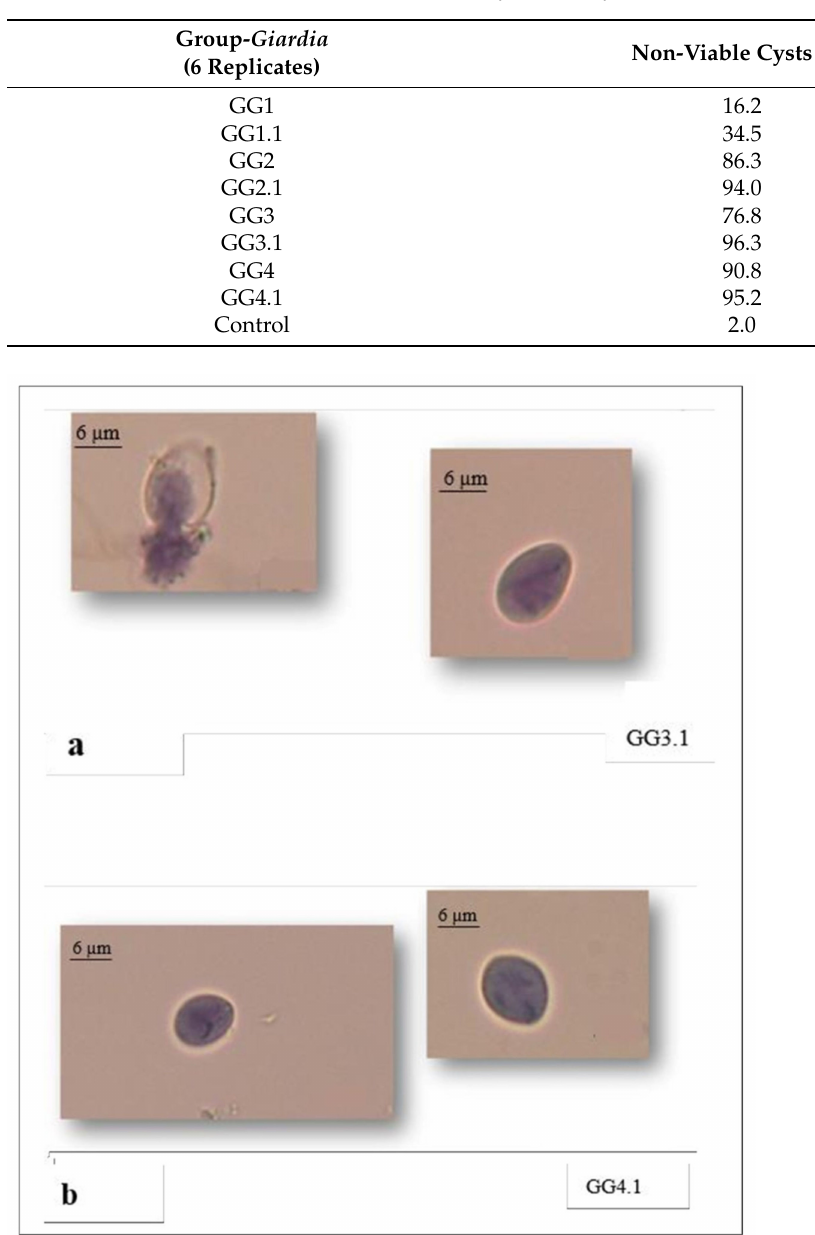
Figure 3. Non-viable cysts of Giardia in GG3.1 ( a ) and GG4.1 ( b ) treated